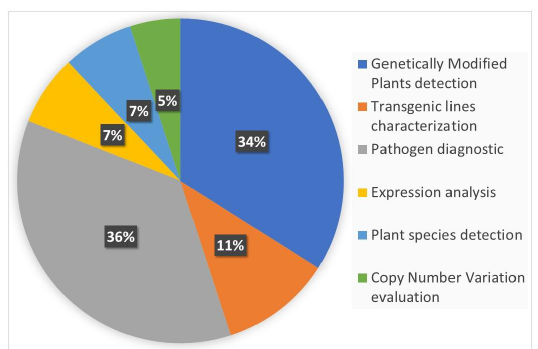
Figure 2. The main applications of digital PCR (dPCR) developed so far in the plant science sector are reported and classified into six main categories. The percentage of each category was calculated on the basis of number of recently published peer-reviewed studies. The literature screening was carried out using dPCR and its variants as main key words for an analysis of the recently published literature.